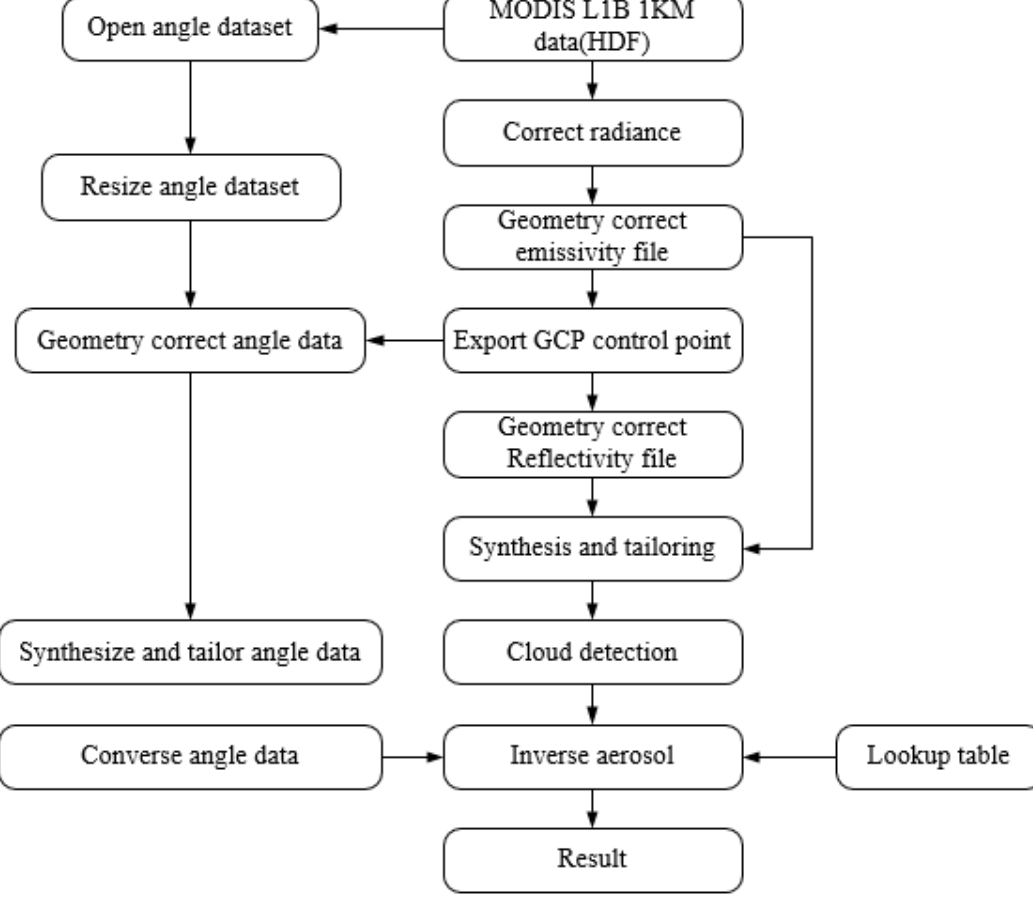
Figure 5. MODIS Level1B data retrieval of aerosol